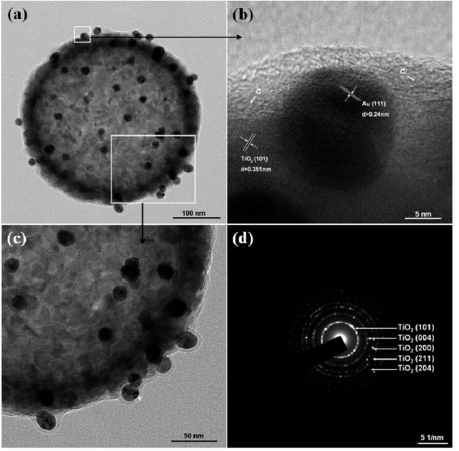
Figure 10. TEM ( a and c ), HR-TEM ( b ), and SAED ( d ) images of double-shelled and sandwiched TiO 2 @Au@C hollow spheres. From Ref. [86]. Reprinted with permission from ACS.